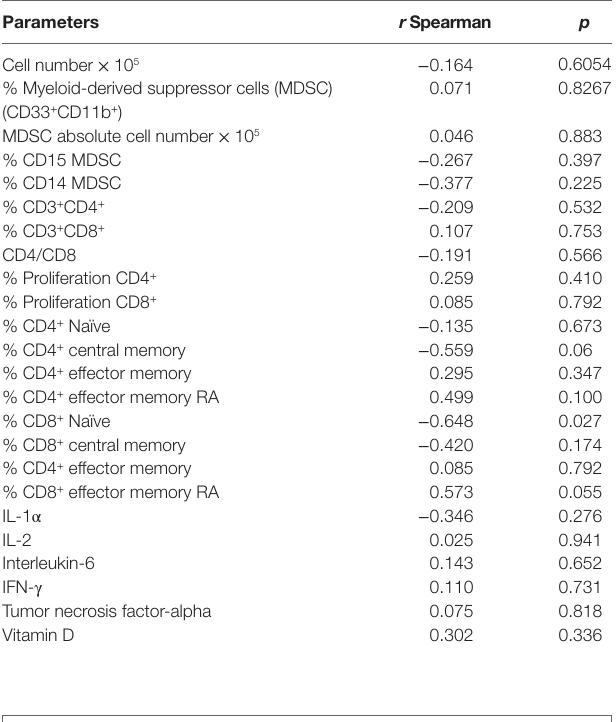
Table 3 | IgG levels against cytomegalovirus and correlation with parameters of the immune system in old (80–100 years) individuals.